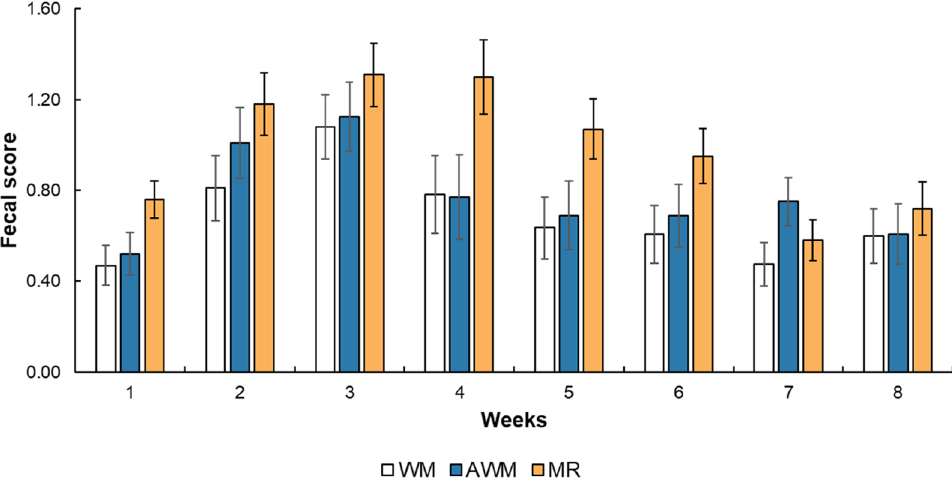
Figure 2. Fecal score of dairy calves fed different liquid diets. *Denotes statistical difference P < 0.05 for the lowest values for AWM and WM and higher than MR.